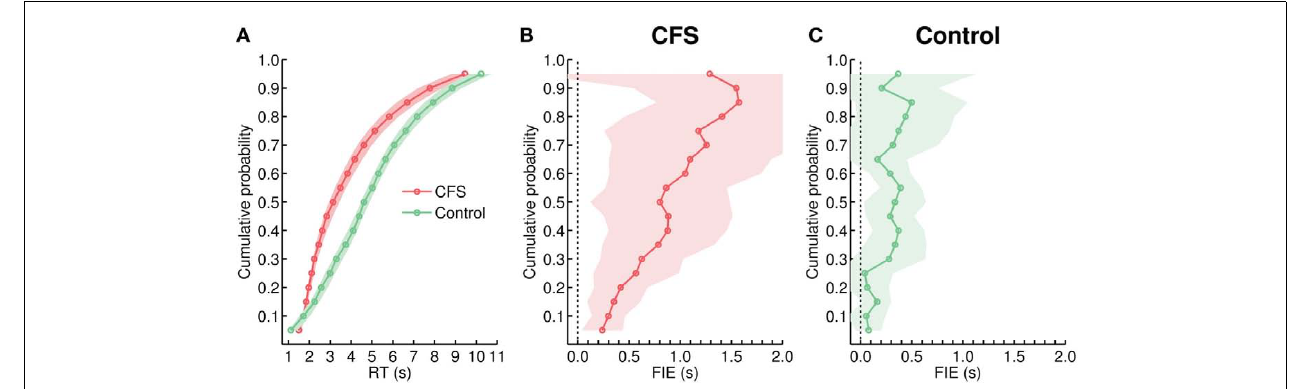
FIGURE 13 | (A) Cumulative group distributions of RTs from the CFS and from the control condition in Experiment 5. (B,C) Size of the FIE as a function of percentiles, plotted separately for the CFS, and the control